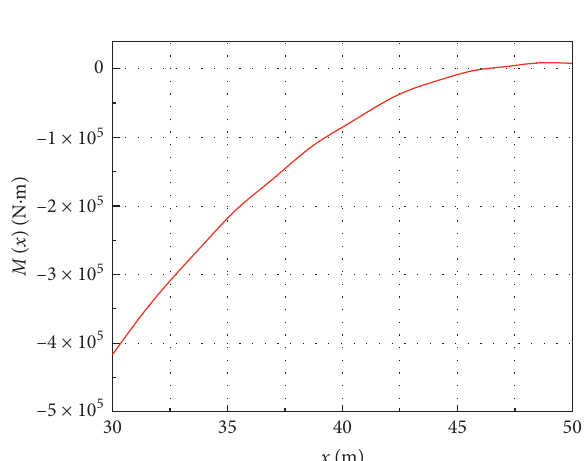
Figure 5: The variation of bending moment (II).